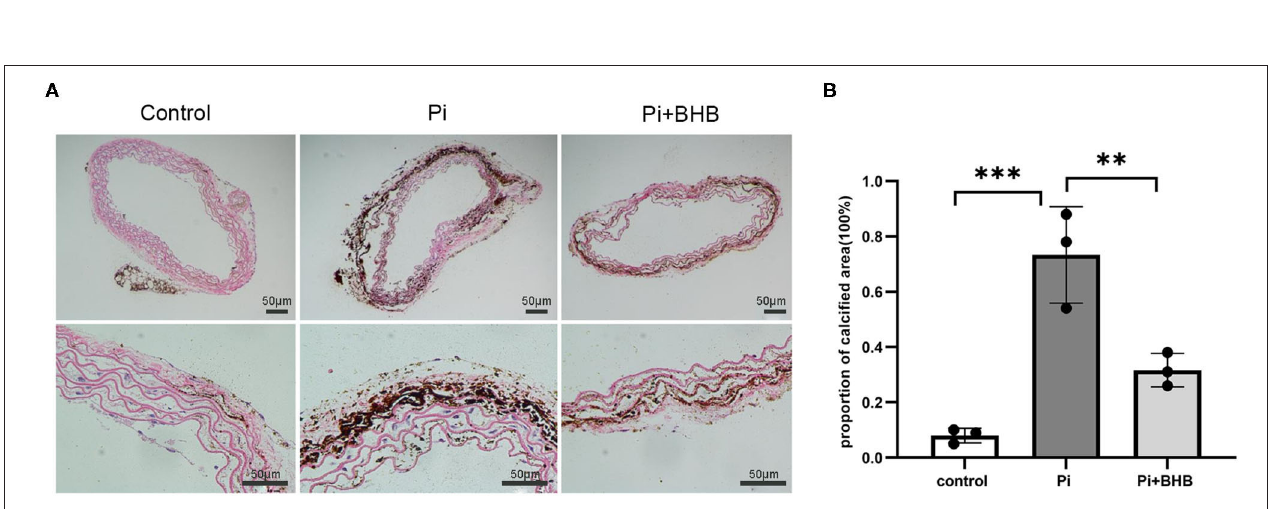
FIGURE 2 | β -Hydroxybutyric acid ameliorated the Pi-induced arterial calcification. (A) Von Kossa staining of arterial rings. Pieces of mice aorta were cultured in calcification medium (Pi: 2.6mM) for 14 days. Scale bar: 50 µ m. (B) Proportion of calcium areas in the total cross-sectional aorta area. The analysis was performed by Image J. Pi, phosphate; ** P < 0.01; *** P <